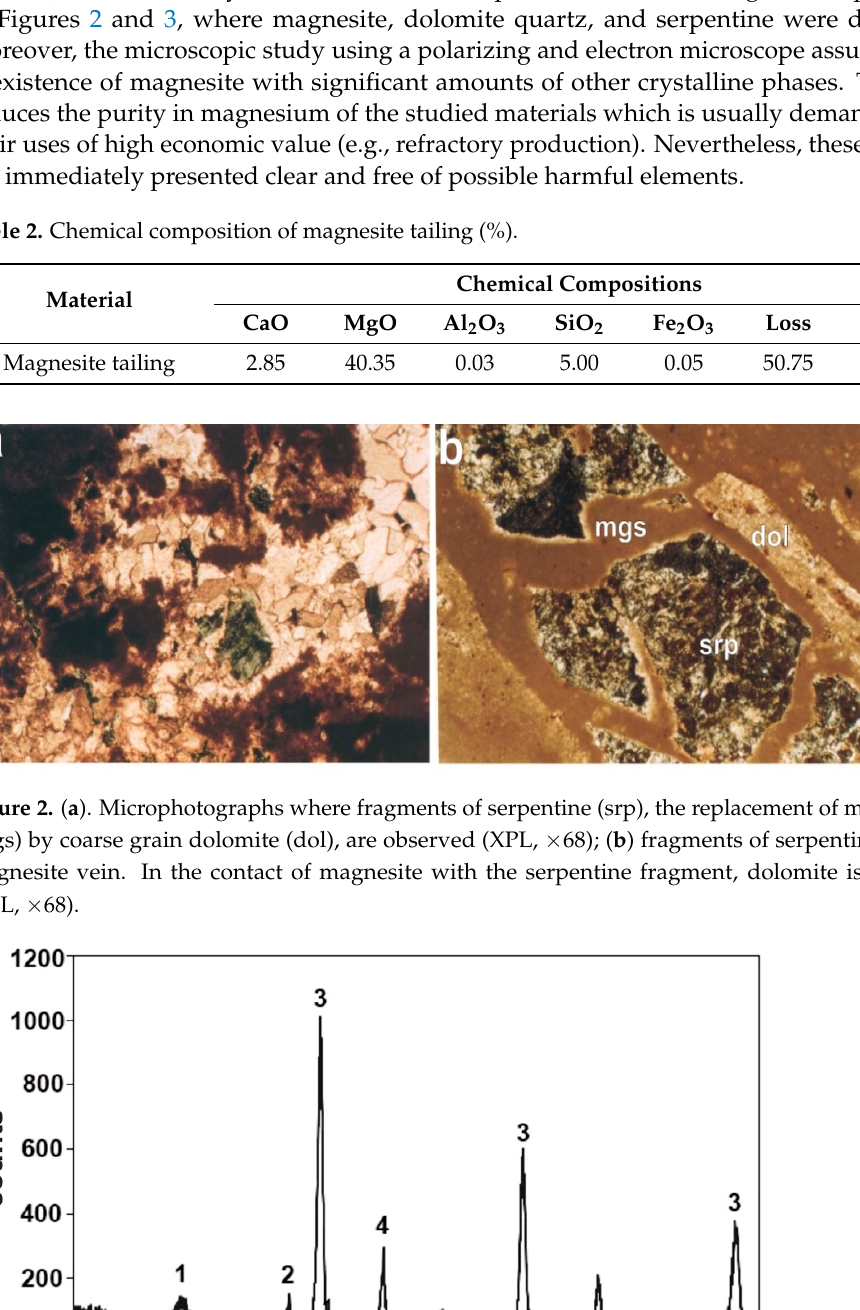
Table 2. Chemical composition of magnesite tailing (%).